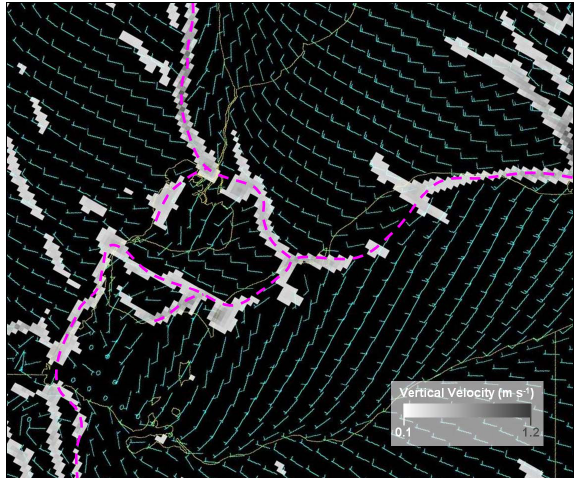
Figure 4. GEM-LAM surface winds (long barb = 5 m s -1 , short barb = 2.5 m s -1 ), upward vertical velocities, and estimated positions of lake-breeze fronts (broken magenta lines) for 15:00 LT on 6 July 2007. The lake-breeze front positions are very similar to observations at the same time, shown in Fig. 3.